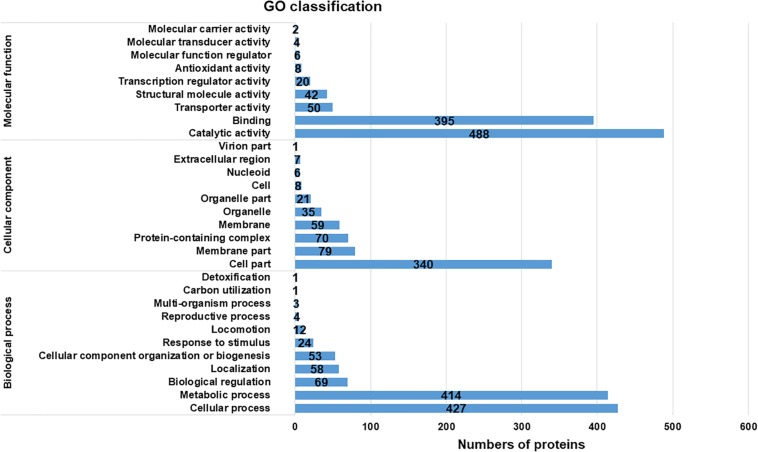
Gene Ontology classification of the total assembled uniproteins.